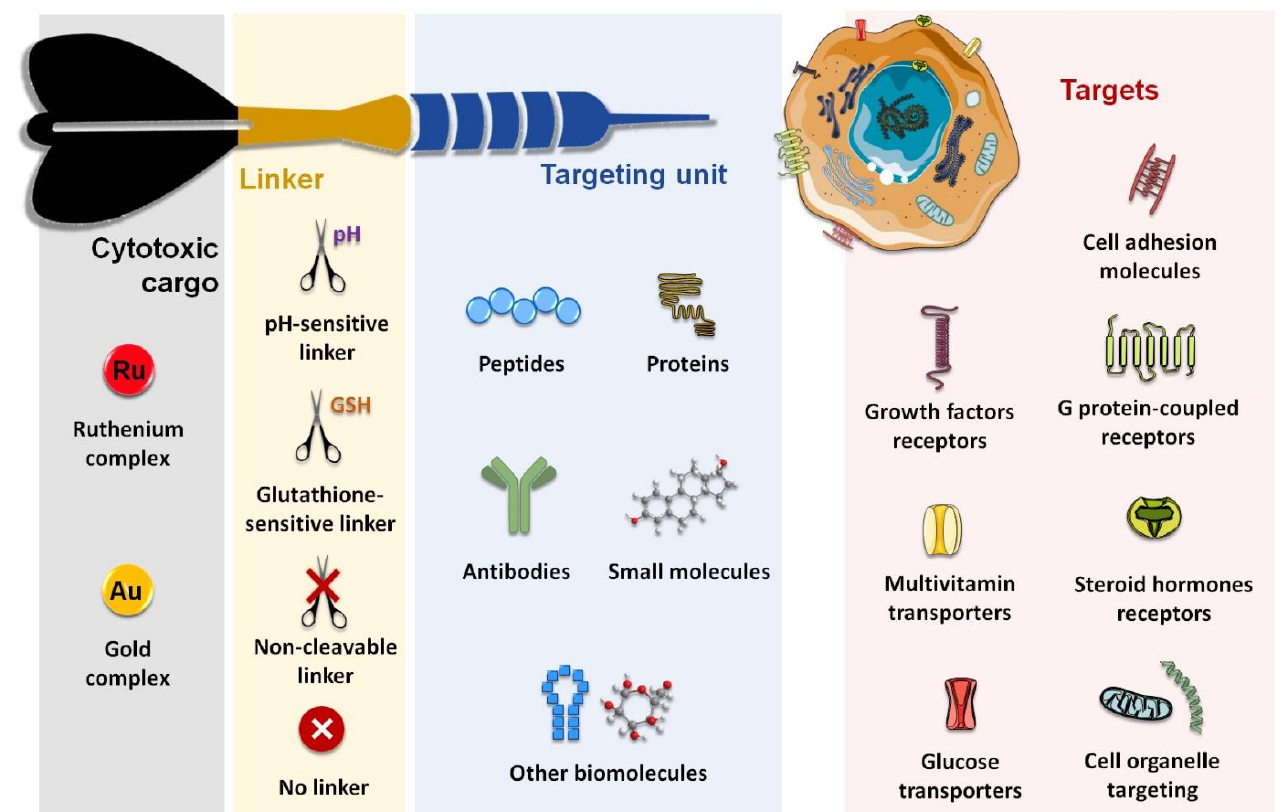
Figure 2. Schematic structure of receptor targeting Ru and Au conjugates .